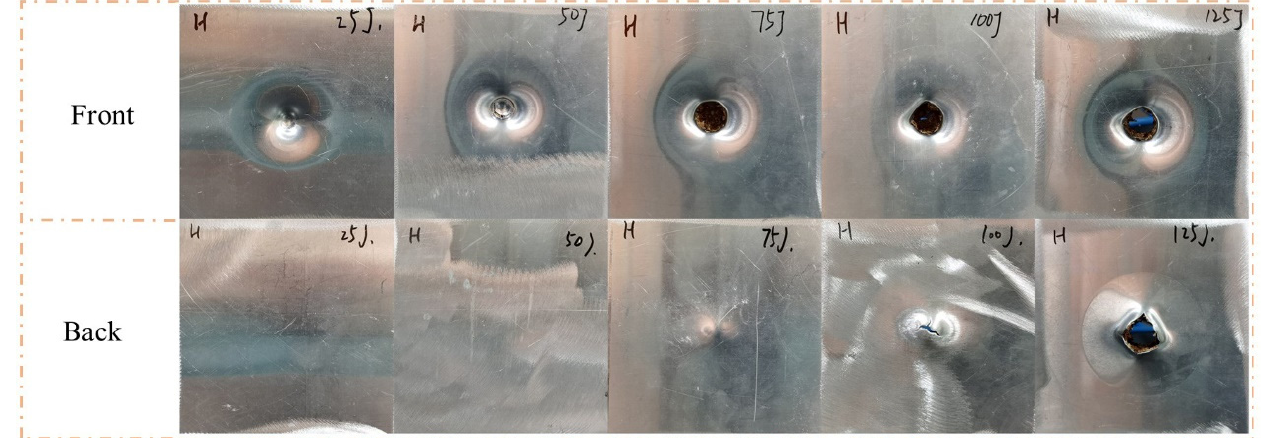
Figure 5. Failure modes of H under five impact energies with a hemisphere impactor.